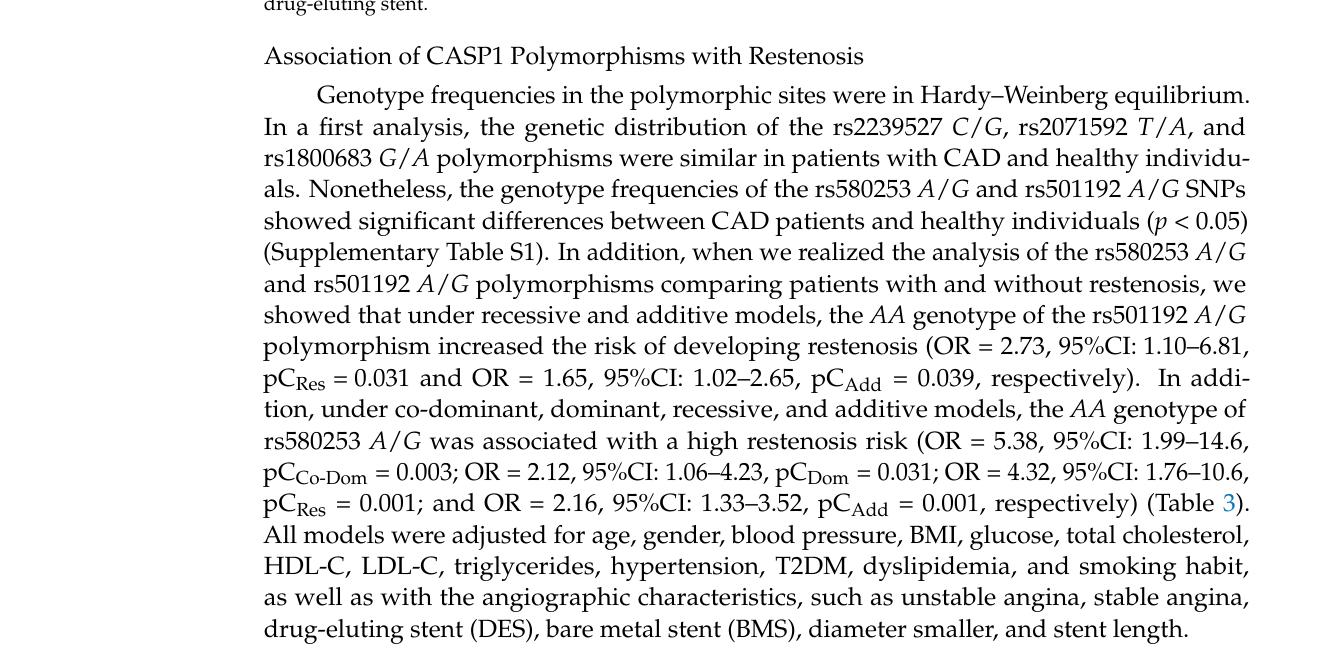
Table 3. The inheritance models analysis of CASP1 polymorphisms in patients with and with- out